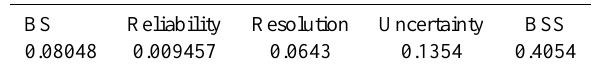
Table 2. Brier Score, BS component values and Brier Skill Score of precipitation over 5mm/24h